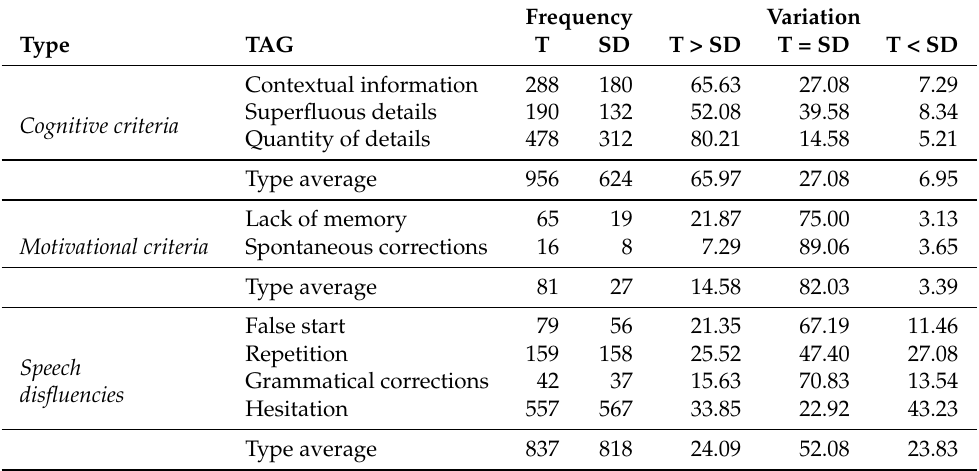
Table 6. Distribution of tags in Truth (T) and Simulated Deception (SD) testimonies and variation analysis.